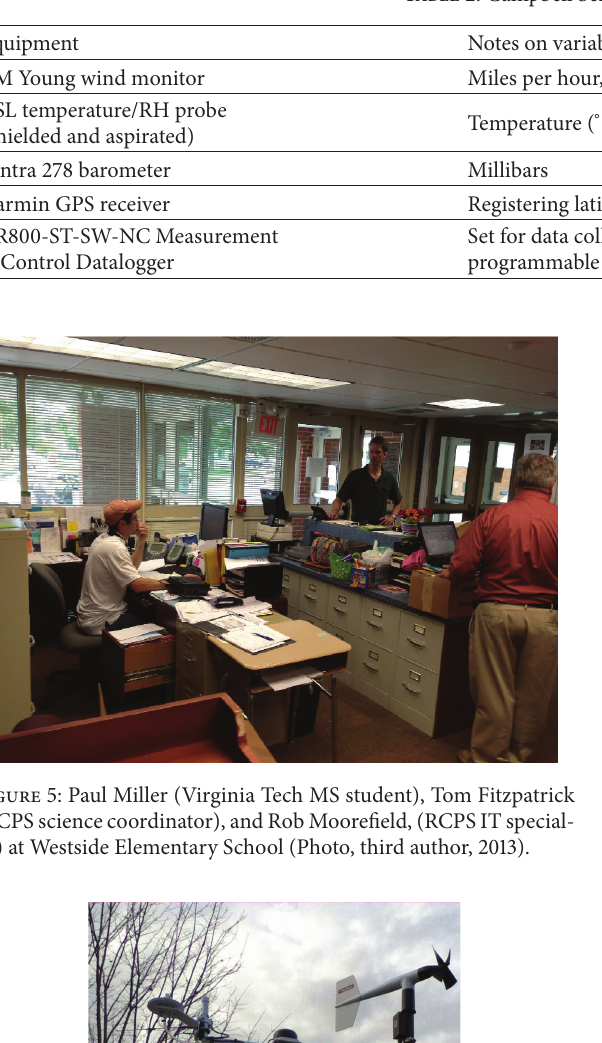
Table 2: Campbell Scientific specifications.